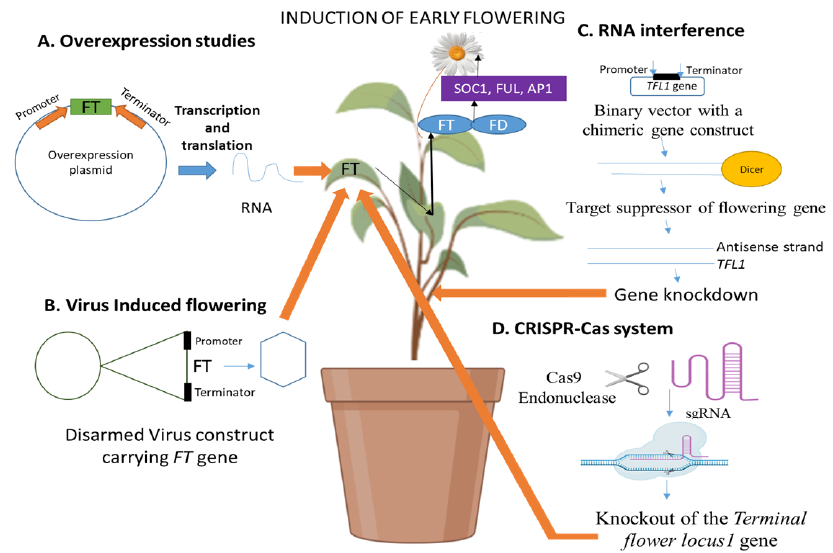
Figure 1. Biotechnological approaches ( A ). Overexpression studies ( B ). Virus-induced flowering ( C ). RNA interference ( D ). CRISPR-Cas system for the reduction of juvenility in perennials .